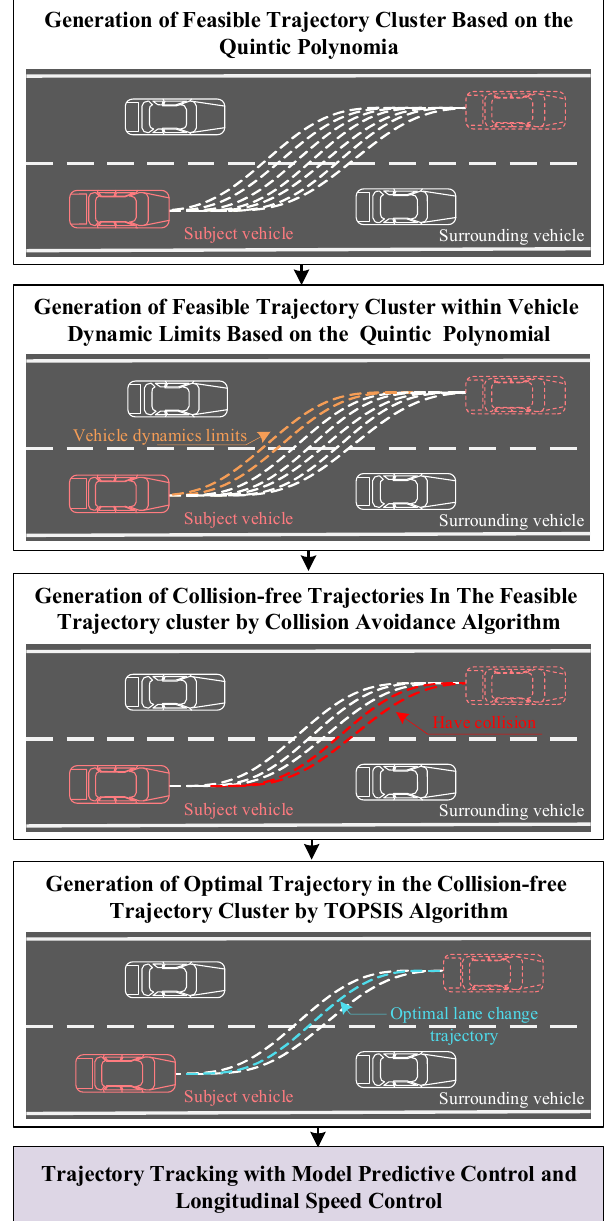
Figure 1. Architecture of the proposed lane-changing trajectory planning system.